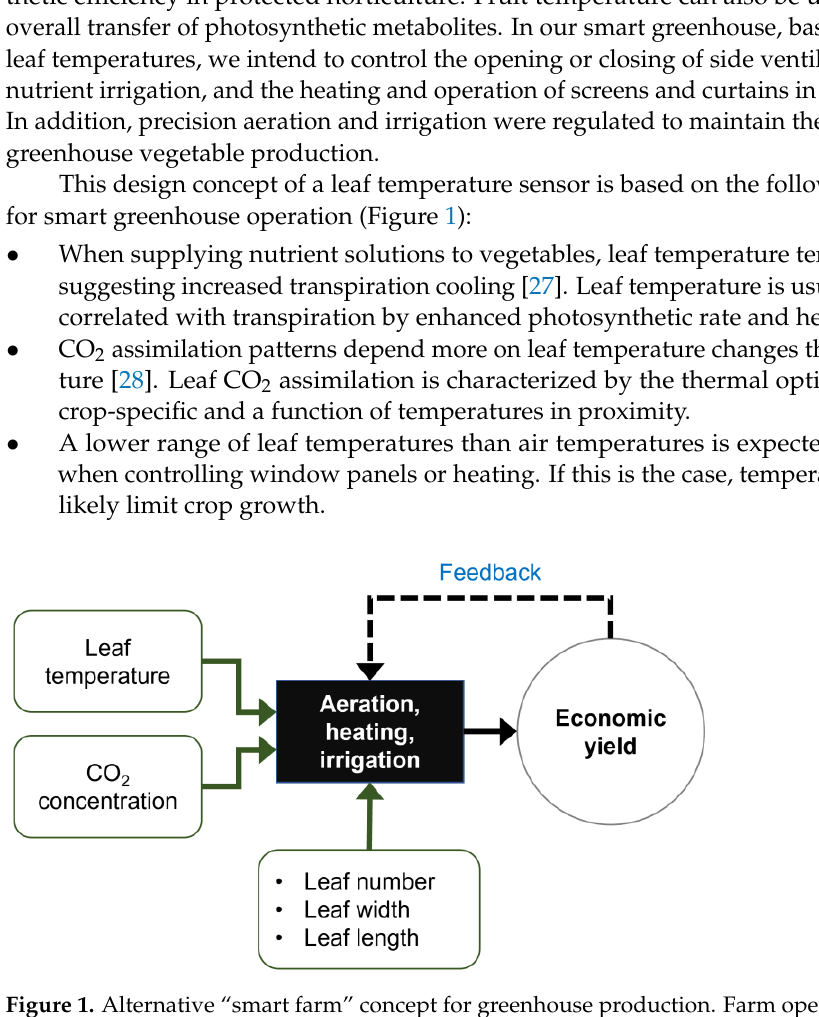
Figure 1. Alternative “smart farm” concept for greenhouse production. Farm operations are based on a sensor network that collects real-time data on the proximal growth environments, such as leaf temperature and atmospheric CO 2 , enabling the precise monitoring of vegetable growth to support management decision making.